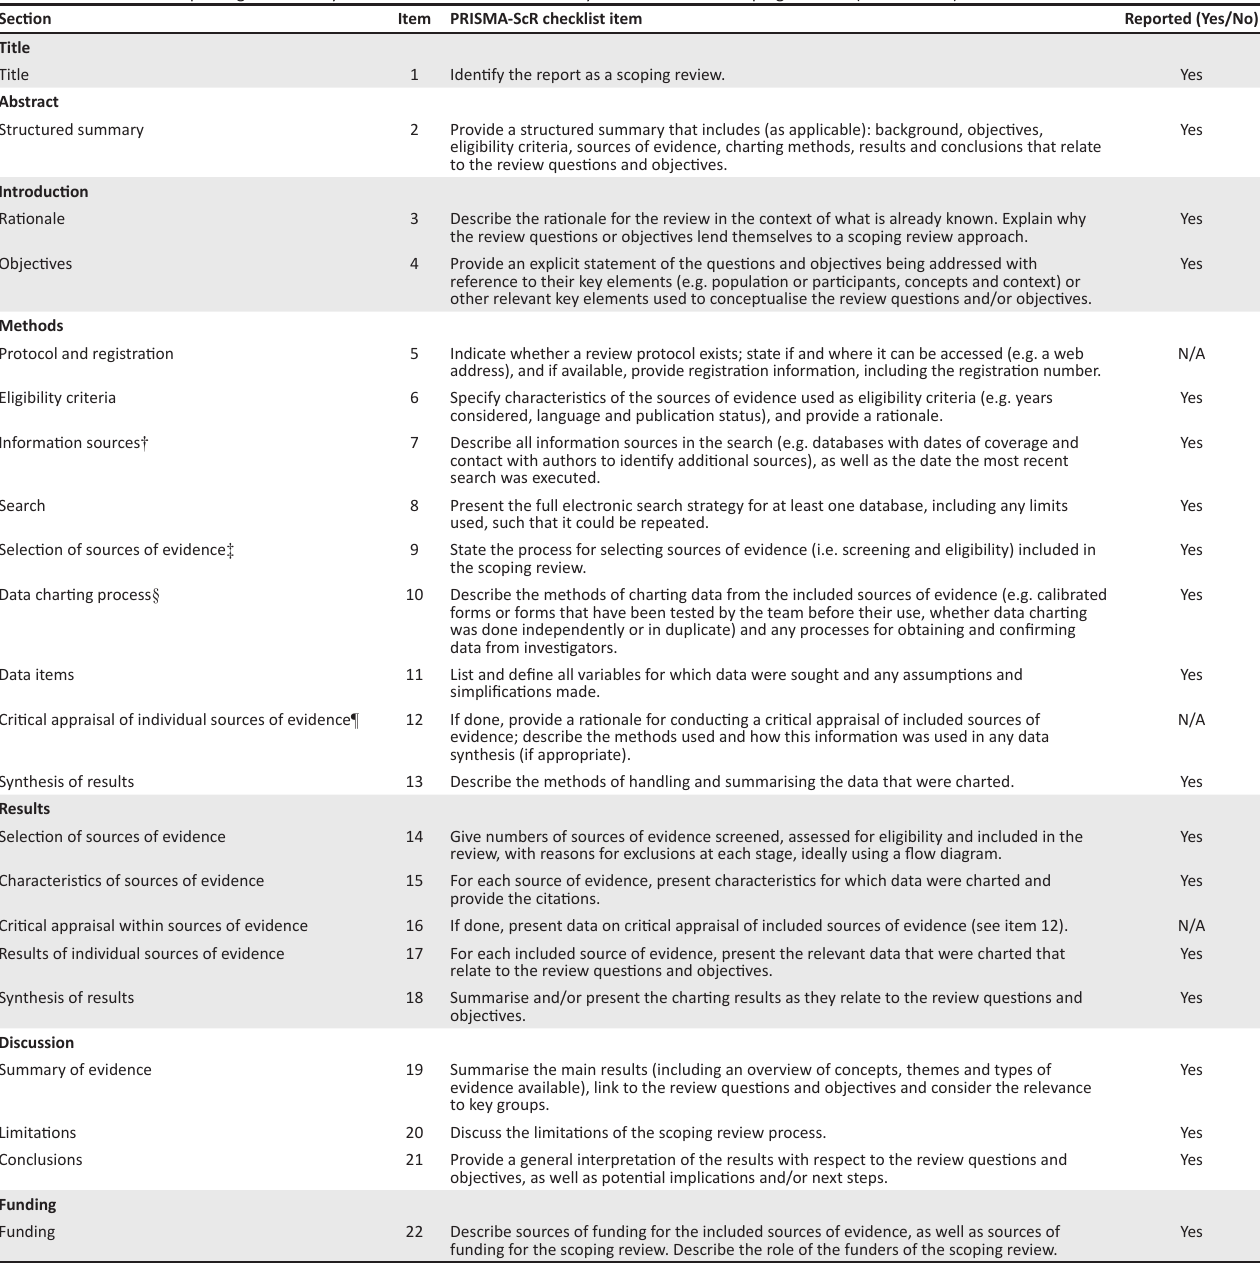
TABLE 1-A1: Preferred Reporting Items for Systematic Reviews and Meta-analyses Extension for Scoping Reviews (PRISMA-ScR)